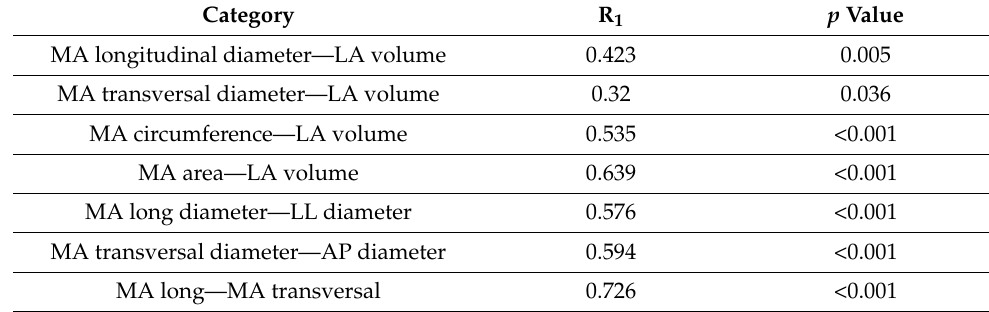
Table 3. Correlations between LA and MA dimensions.